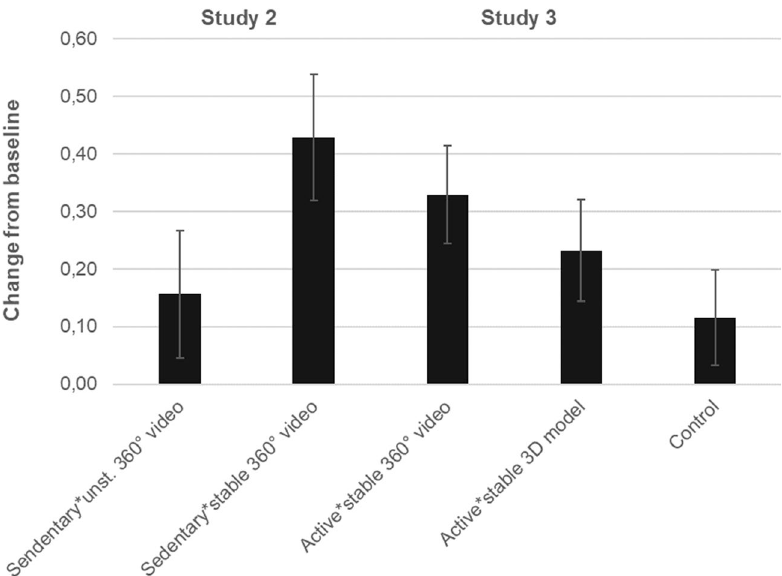
Figure 2. Changes from baseline in general green exercise intention, measured using the Intention to Perform Green Exercise Questionnaire 41 before and after the VR exposure, in relation to different experimental conditions (EMM ± SE, as corrected for PA-levels). Left = Study 2; Right = Study